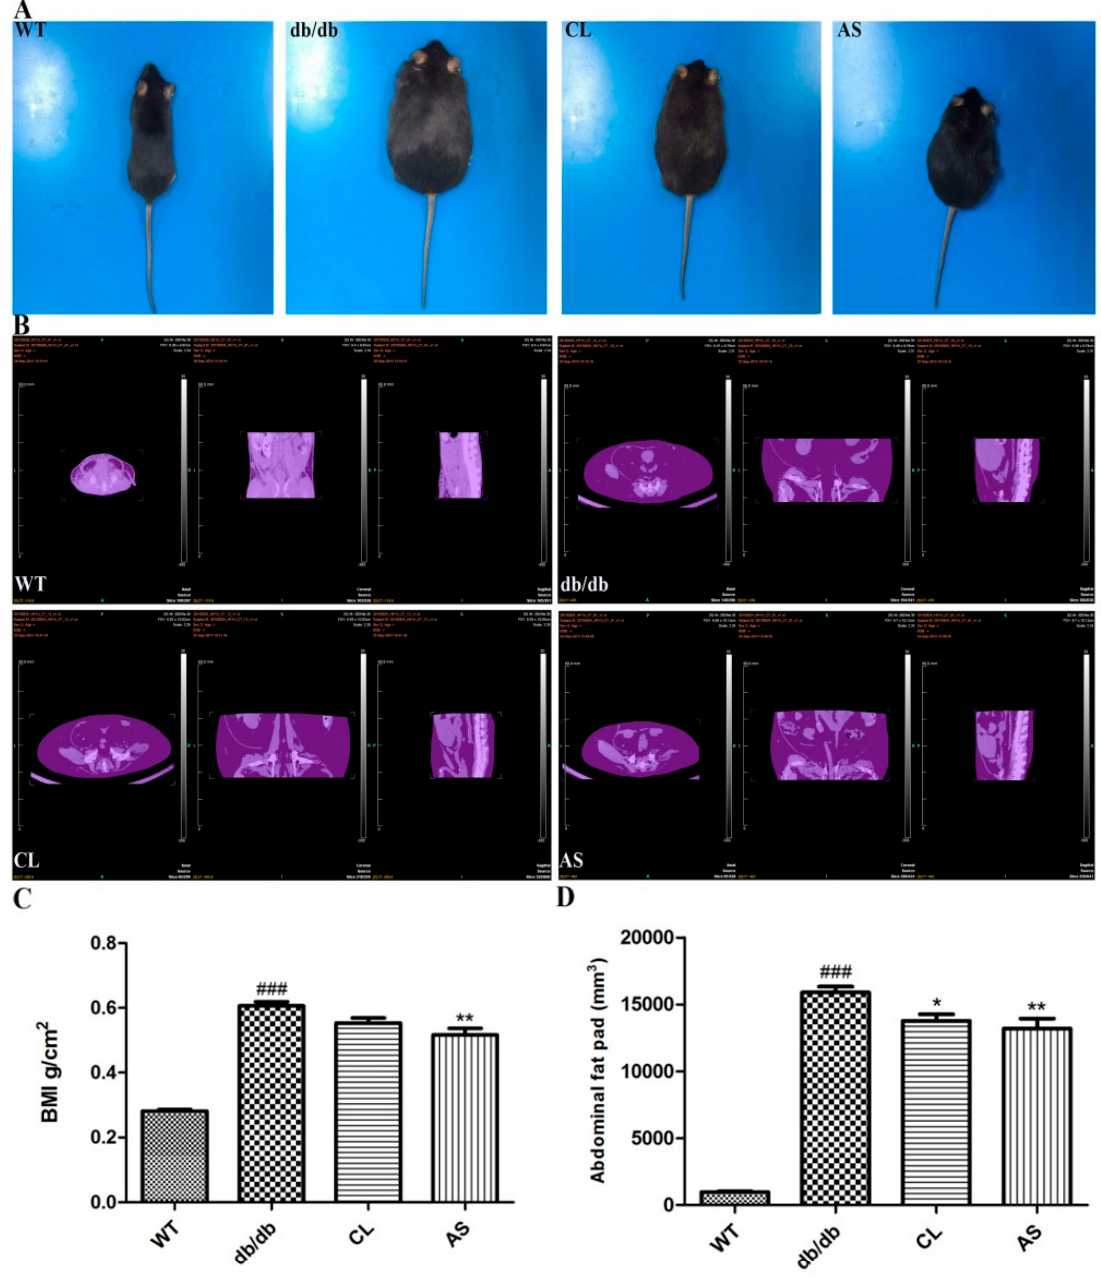
Figure 3. Effect of AS on abdominal adiposity in db/db mice. ( A ) mice images were acquired by a digital camera at the end of experiment; ( B ) micro-computed tomography (CT) images of abdominal fat of mice in WT, db/db, CL, or AS group; ( C ) BMI = weight (g)/length/length (cm 2 ); ( D ) fat volumes (mm 3 ) in mice are shown. The values represent the mean ± SEM ( n = 6). * p < 0.05, ** p < 0.01 vs. db/db group; ### p < 0.001 vs. WT group.